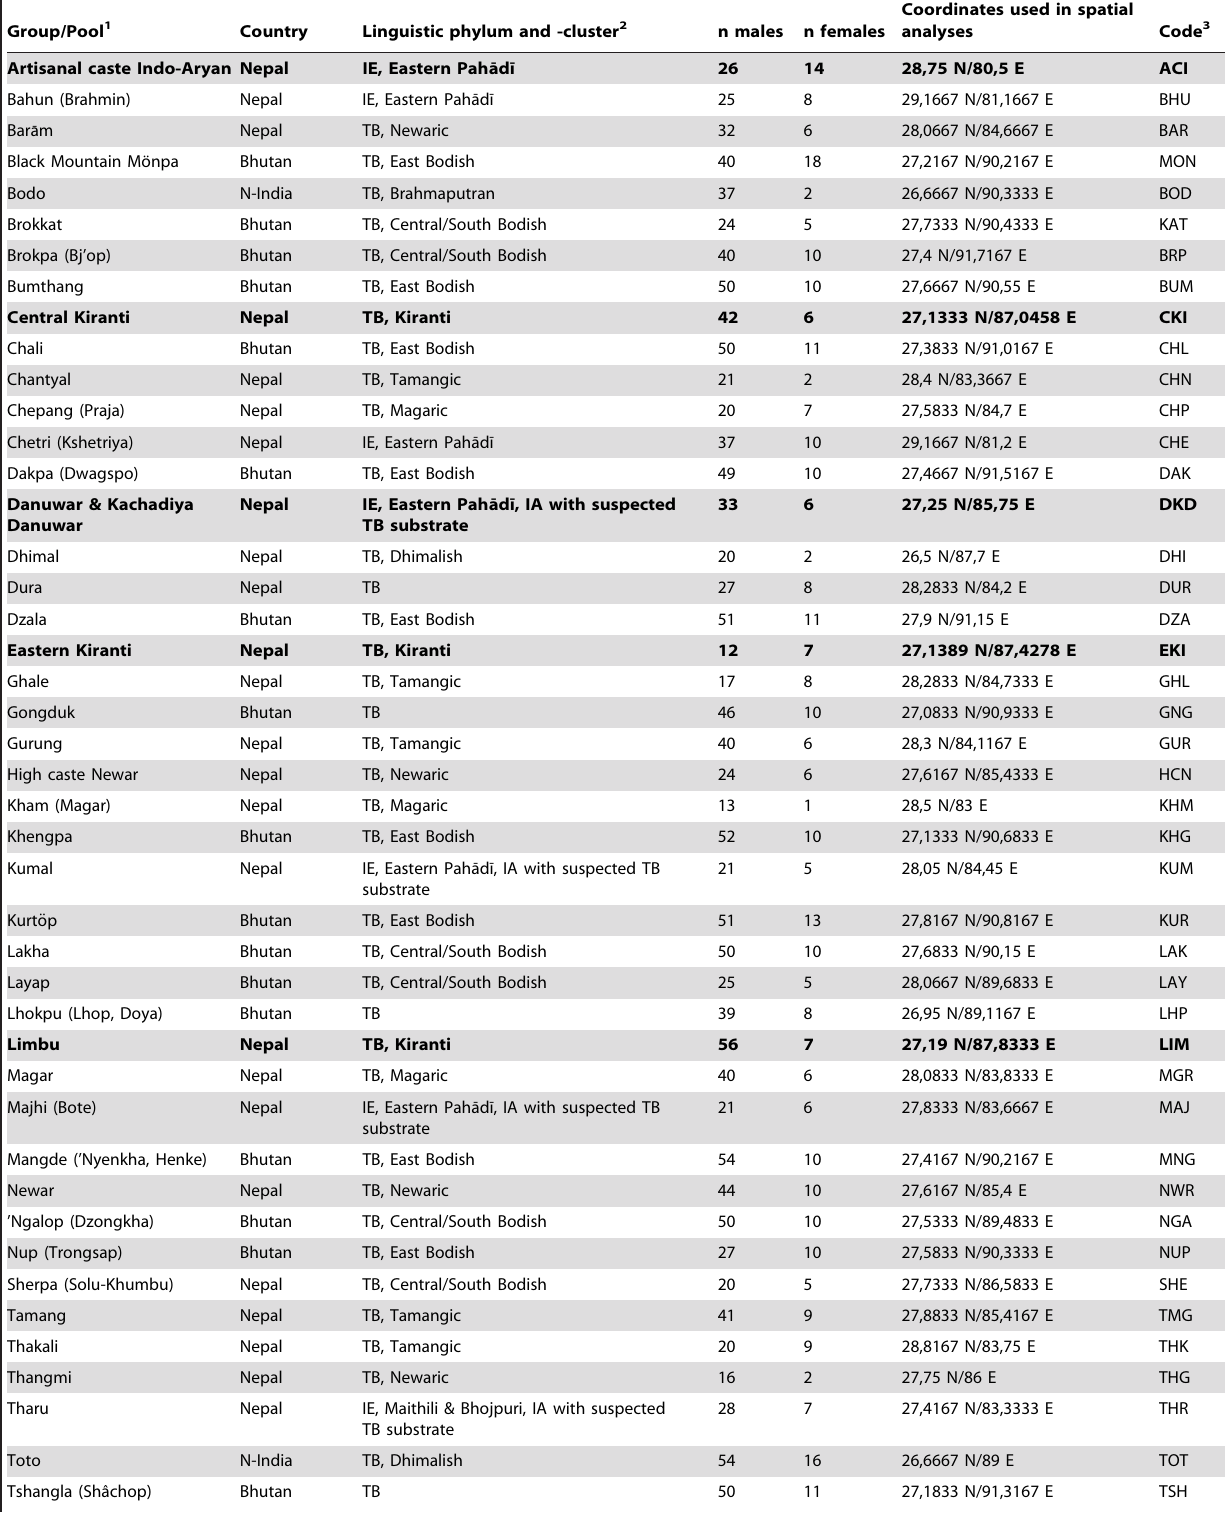
Table 1. Group names and numbers of samples collected in Nepal and